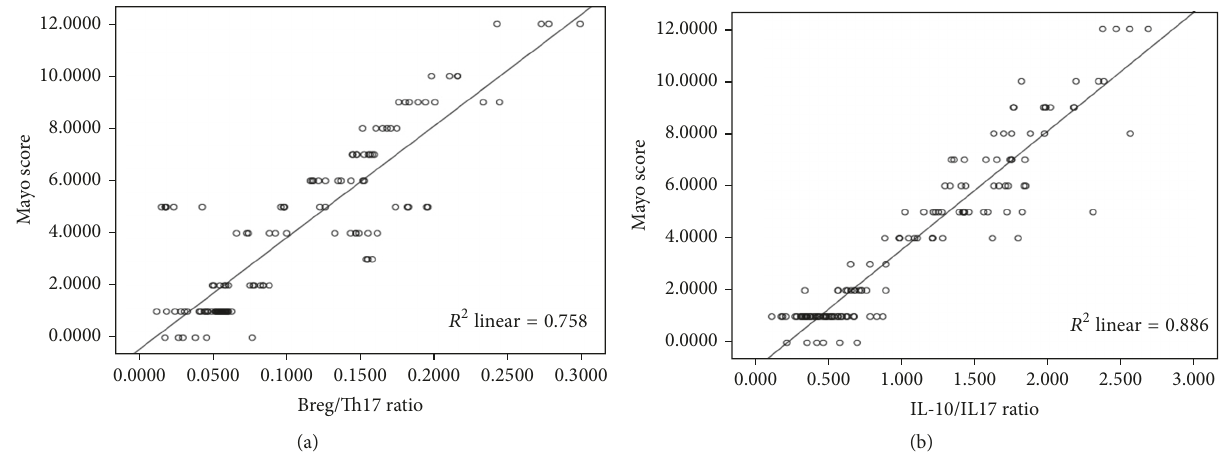
Figure 6: Correlation of cell counts and cytokine levels with Mayo scoring in ulcerative colitis patients, B10/Th17 ratio, and Mayo scoring were positively correlated; serum IL-10/IL-17 ratio and Mayo scoring were positively correlated. (a) Peripheral blood B10/Th17 ratio was positively correlated with Mayo in ulcerative colitis patients ( 𝑟 = 0.758 , 𝑃 < 0.05 ). (b) Serum IL-10/IL-17 ratio was positively correlated with Mayo in ulcerative colitis patients ( 𝑟 = 0.886 , 𝑃 < 0.05